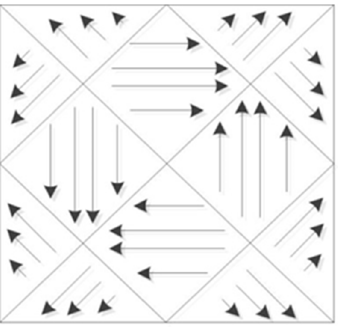
Figure 3. Schematic diagram of partition scanning